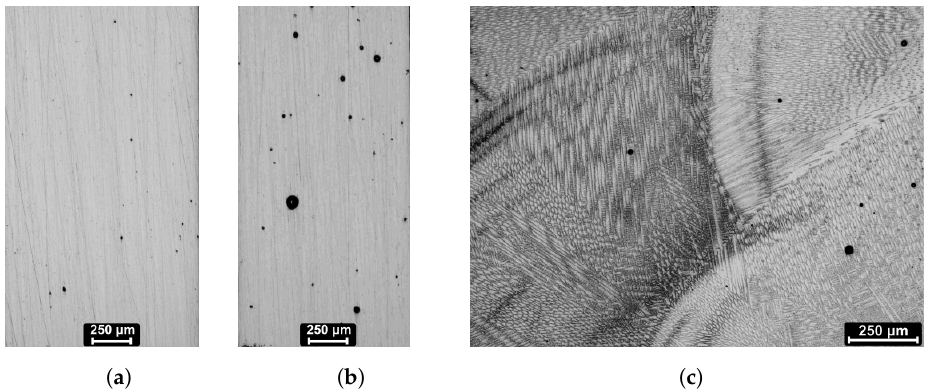
Figure 12. Optical microscopy images: ( a , b ) near the bottom and close to the middle of the printed wall; and ( c ) distribution of dendritic structure in different orientation observed in some neighbouring fused